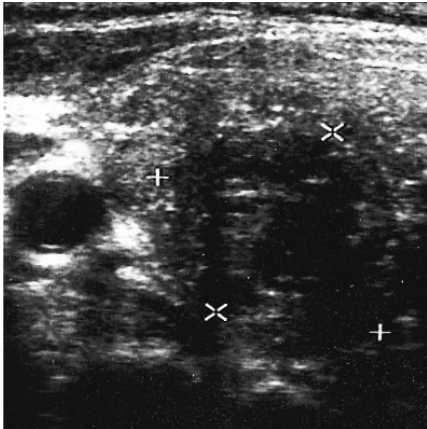
Figure 3: Ultrasound finding of parathyroid carcinoma (trans- verse)—an intrathyroid, nonhomogeneous, fibrotic mass in the right lobe.